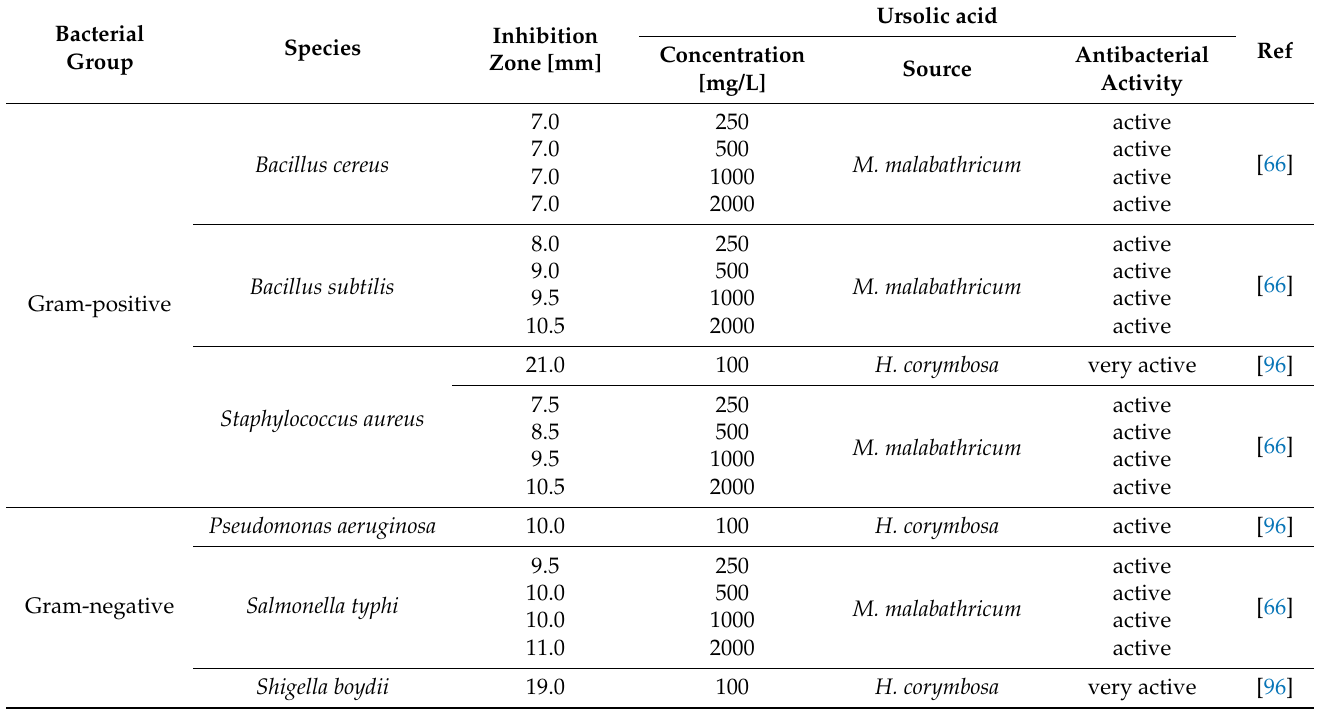
Table 4. Growth inhibition zones and corresponding concentration values of ursolic acid against Gram-positive and Gram-negative